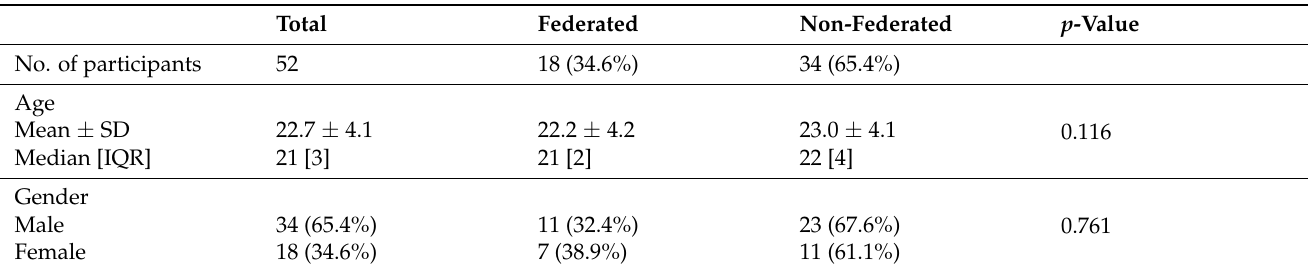
Table 1. Demographic data of the study